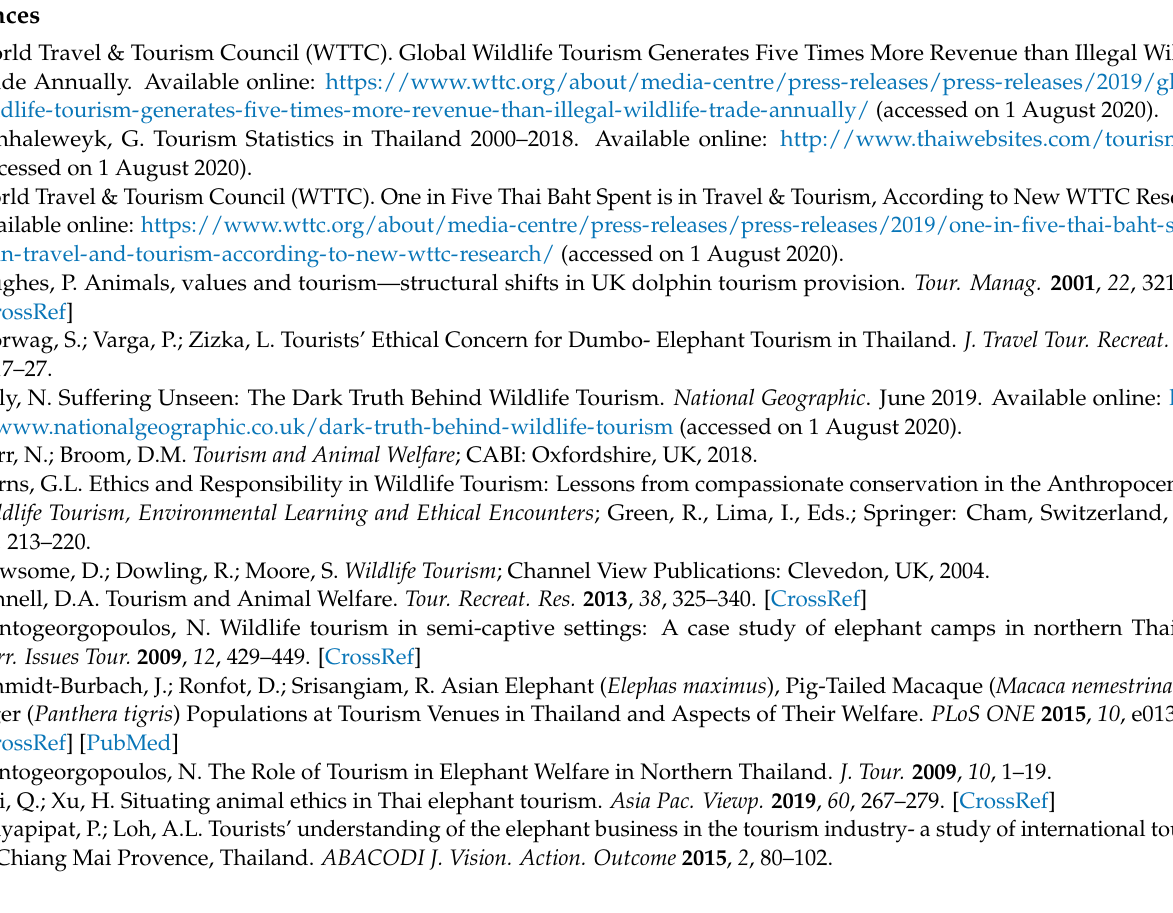
Table S2: Reasons respondents gave for choosing their least preferred activity. Table S3: Respondent preferences, per venue type, for riding or not riding an elephant in future. Table S4: Reasons respondents gave for not riding an elephant in future. Table S5: Ranking of ETVs based on the tourists’ satisfaction with the venues. Table S6: Reasons respondents gave for willingness to return to the ETV they visited. Table S7: Reasons respondents gave for not returning to the ETV they visited. Table S8: Reasons respondents gave for believing the ETV they visited treats their elephants appropriately. Table S9: Reasons respondents gave for being unsure whether the ETV they visited treats their elephants appropriately, the Pre-Visit and Post-Visit Questionnaires, the Tourist Questionnaire Information Sheet, and the ETV Recruitment Email